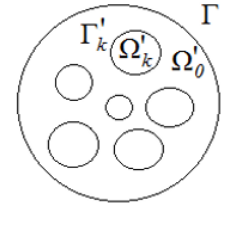
Fig. 2. Geometric model of representative volume of